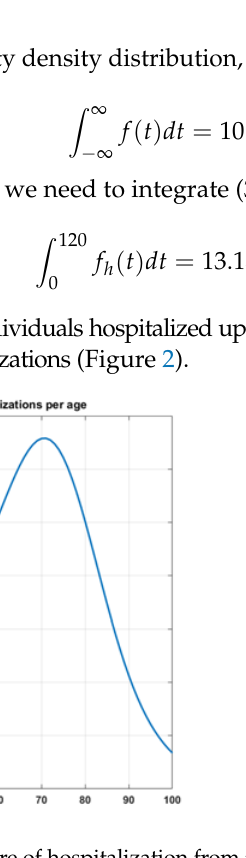
Figure 2. Distribution of the share of hospitalization from the total cases up to 3 September 2021 f h ( t ) g. With this distribution, the share among 60+ is 66.66%, which is cumulative for 3.09%. The same share in the new cases is 52%. Thus, we can see disproportionally many patients over the age of 60 with the model of